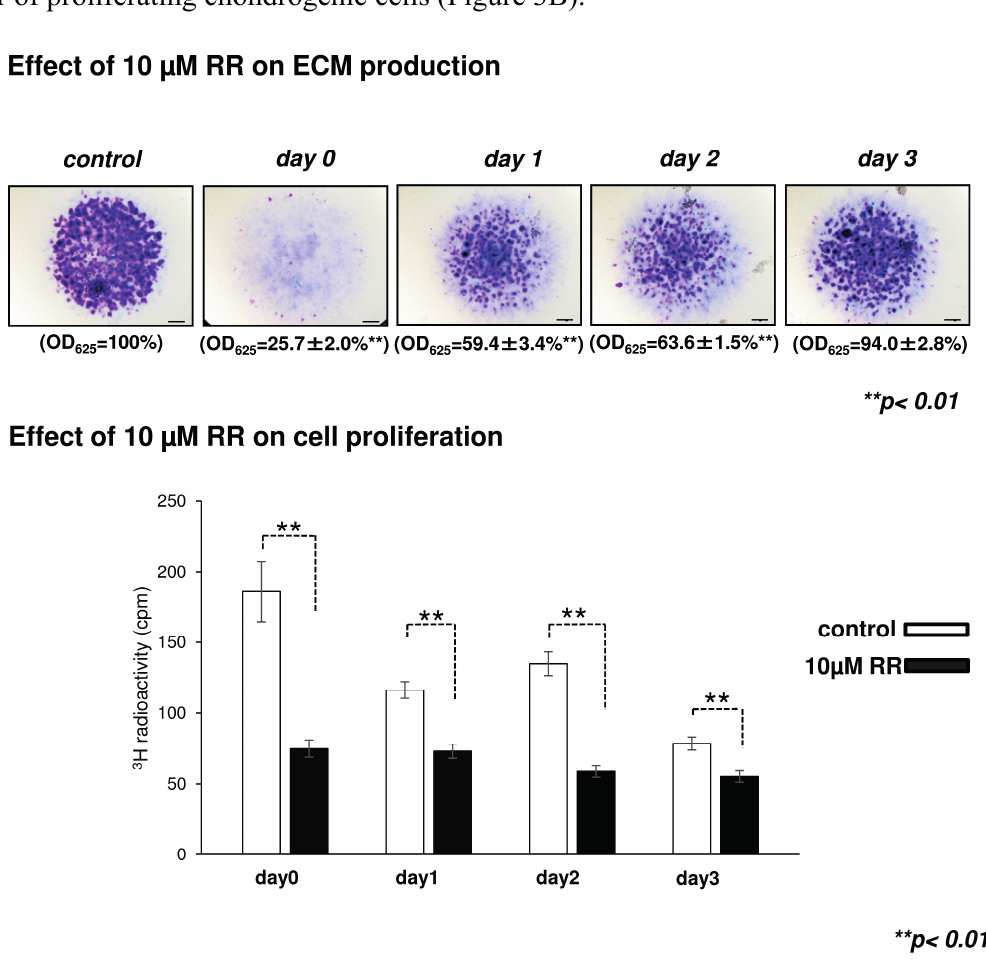
2.3. Effect of Ruthenium Red, a General TRPV Inhibitor, on Chondrogenesis Ruthenium red (RR), a broad-spectrum calcium channel inhibitor, was administered for 24 h on different days of culturing at a concentration of 10 µM. We measured its effect on matrix production and proliferation. Application of RR on the first three days of culturing significantly reduced the amount of metachromatically stained proteoglycan-rich ECM (Figure 3A) and also caused a significant decline in the number of proliferating chondrogenic cells (Figure 3B).